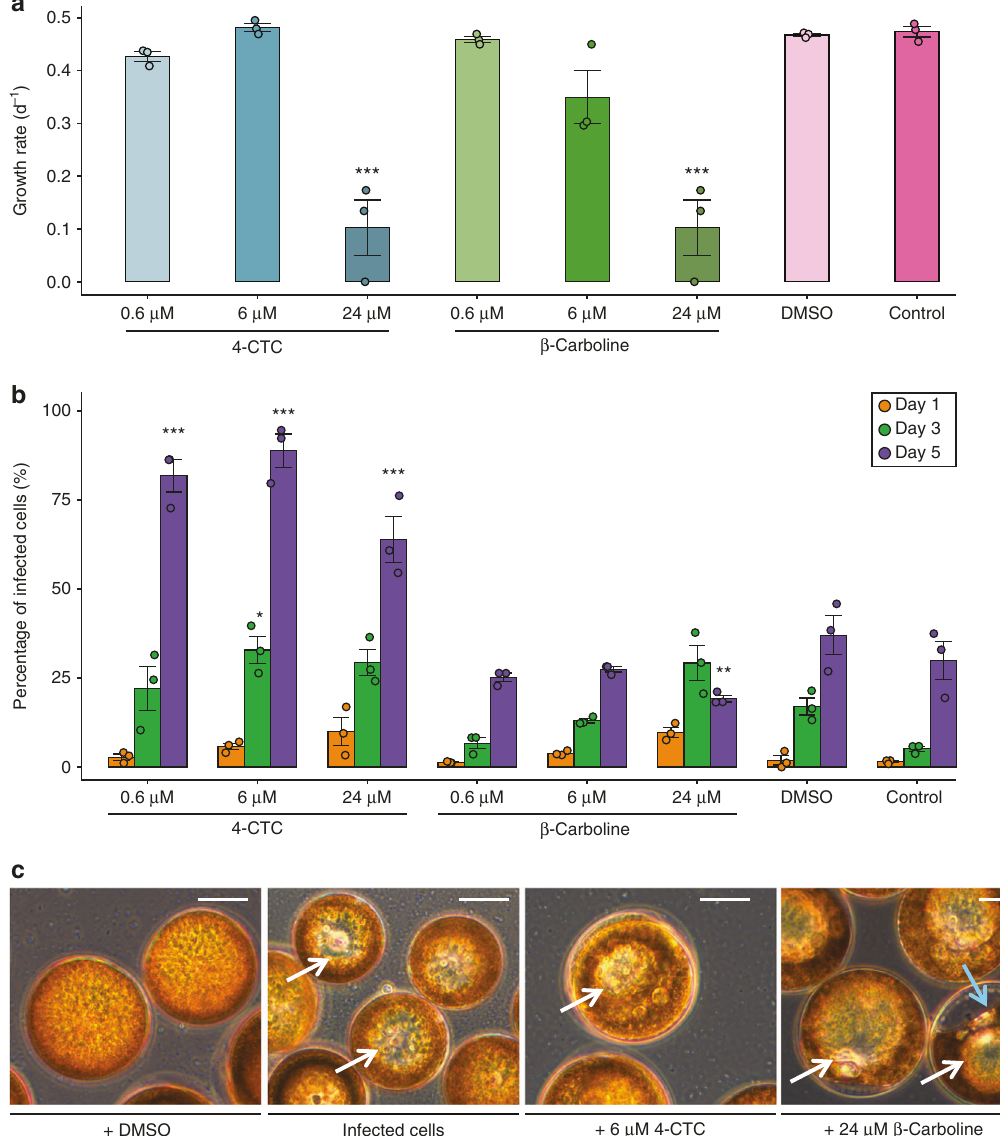
Fig. 3 Functional assays showed that the carbolines impact the growth, morphology, and infection rate of the marine diatom C. granii . a β -Carboline and 4- CTC inhibit the growth of C. granii algal cells at 6 and 24 µ M, respectively (mean growth rates ± SE, one-way ANOVA with multiple comparisons against the DMSO group, Holm – Sidak method, F = 26, dF = 8, n = 3, *** for p value >0.001). b The infection rate was elevated in cultures treated with 4-CTC (>6 µ M) after 3 and 5 days of incubation. Statistical tests, a two-way repeated measures ANOVA with pairwise multiple comparison ( F = 17, dF = 8, n = 27) and the Dunnett ’ s method with multiple comparisons against the DMSO group found signi fi cant differences with the treatments highlighted by *** for p -value <0.001, ** for p value <0.01, * for p value <0.05. Mean of the infection rates was determined ±SE. c The phenotype of cells treated with β -carboline at 24 µ M and 4-CTC (6 µ M) (pictures on the right) was similar to the untreated infected cells (second picture from left). Plasmolysis was observed with vacuolization (white arrows) and some cytoplasmic detachment (blue arrow). Scale bars equal 20 µ m, representative pictures of three replicates are coscinodisci strain LagC7 is available as freeze-dried sample and the specimen was rate was followed over 4 days by light microscopy. Cell densities were counted in a deposited in the Senckenberg Museum of Natural History, Cryptogams Section, Sedgewick Rafter Counting Chamber (Pyser-SGI). Frankfurt am Main, under the number FR-0046113. Co-culture experiments . Co-culturing chambers consisting of two separate vessels Infection experiments . To assess the effect of the exometabolome of infected algal separated by a 0.22 µm pore-size membrane sterile fi lter (Millipore) were built and cultures on the growth and resistance of C. granii , 5-day-old-infected C. granii assembled as described in detail in Paul et al. 24 but with a scaled-down total volume of 240mL. The experiments were conducted in six biological triplicates. For as follows. The cell density of exponentially growing healthy culture was deter- mined and the cells were harvested by pouring the culture in 40µm pore-size nylon mesh (Corning Life Sciences), washed with 20 mL sterile seawater, inoculated in 30 mL spent medium at a fi nal concentration of 10 cells mL − 1 . Growth was monitored over 8 days. To verify the infection rate after 5 days, three samples of treated cells and controls were infected with 2.6mL of an LagC7 infected culture. The infection